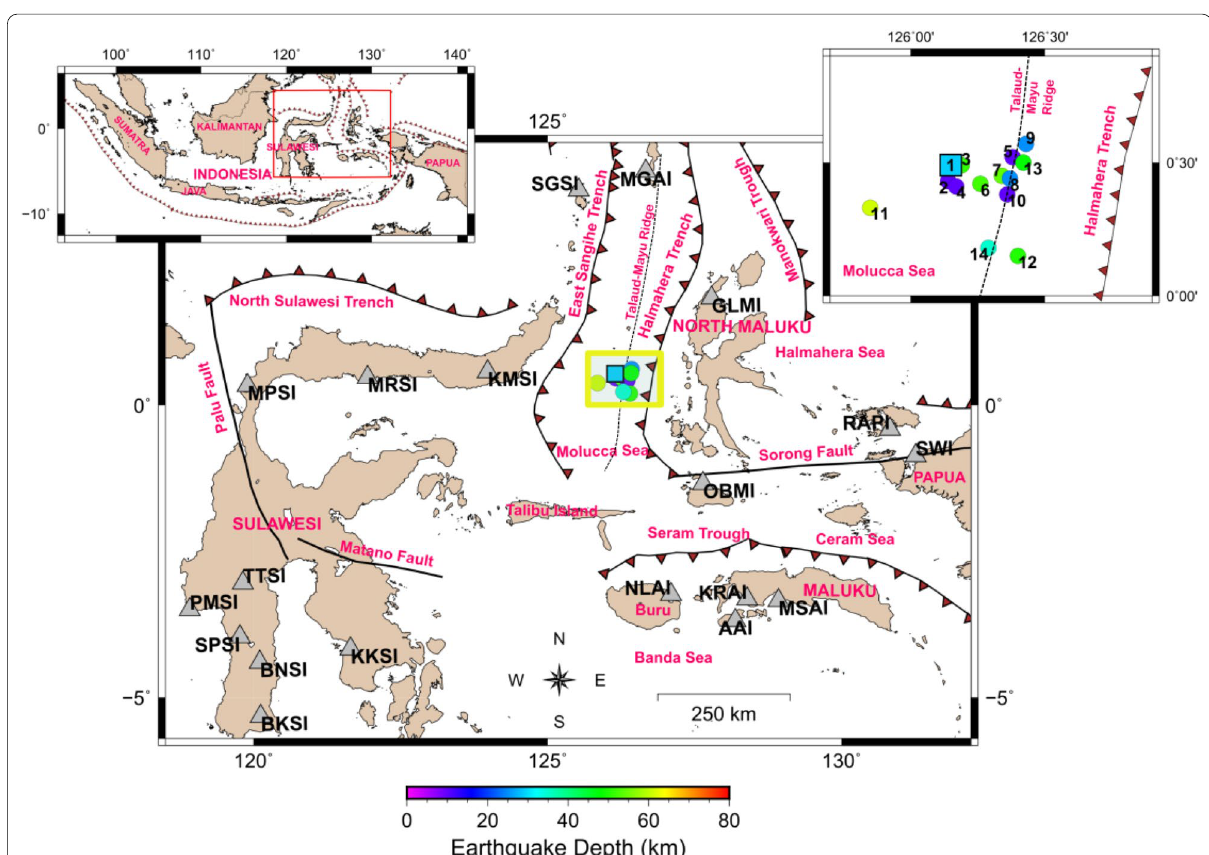
Fig. 2 The tectonic setting of study area with the black lines representing the plate boundaries and the black dashed line showing the Talaud-Mayu ridge. The inset at the right top shows the zoom-in of the yellow rectangular area in the main figure. The right top inset displays the Earthquakes with Mw > 4 in the Molucca Sea recorded during July 7–18, 2019, as shown by the colored dots and numbered in time sequence from 1 to 14. The earthquakes information is obtained from the GFZ catalog. The mainshock is indicated by a blue rectangular. The gray triangles indicate the seismic stations of the IA-Network. The inset figure at the left top of the main figure indicates the area of investigation, which is marked by the red rectangle